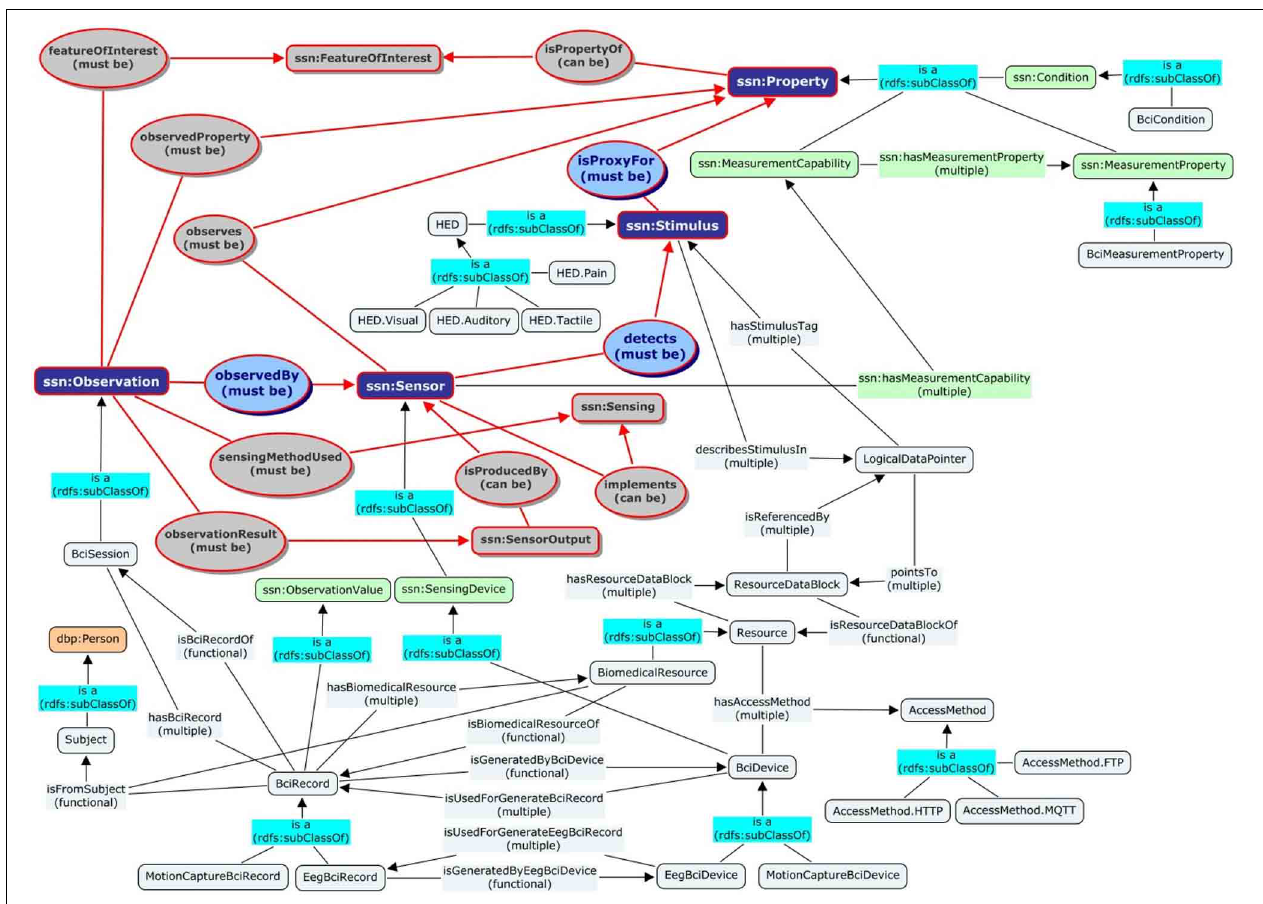
FIGURE 2 | Alignments between the proposed BCI Ontology and the SSN Stimuli-Sensor-Observation ontology design pattern. The directed graph depicts the relations (edges) among the cores concepts/classes (rounded-square nodes) from different namespaces including the default BCI namespace (sky-blue colored nodes), the SSN namespace (colored nodes with ssn prefix), and the Dbpedia namespace (tan colored nodes with dbp prefix). The sub-graph with red outlines